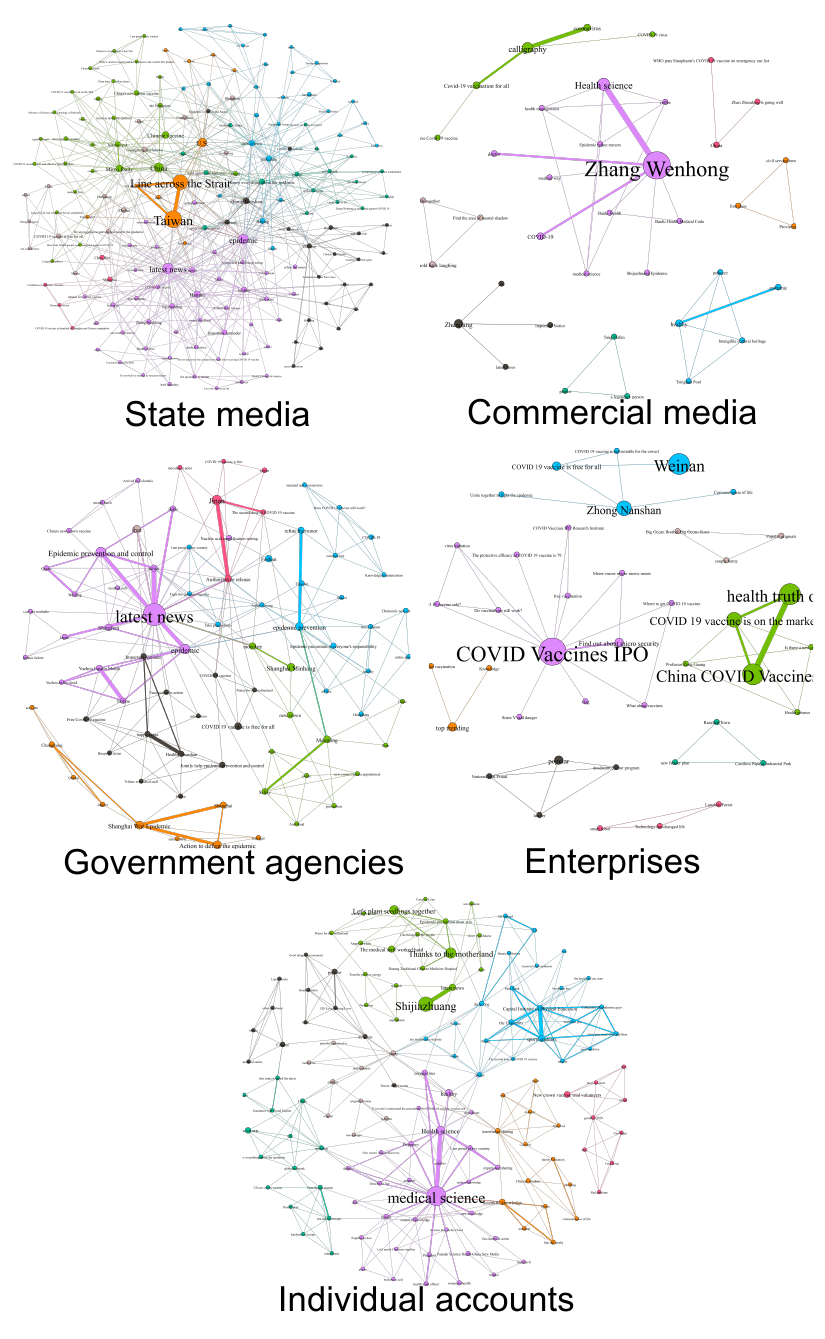
Figure 2. Hashtag co-occurrence network by account